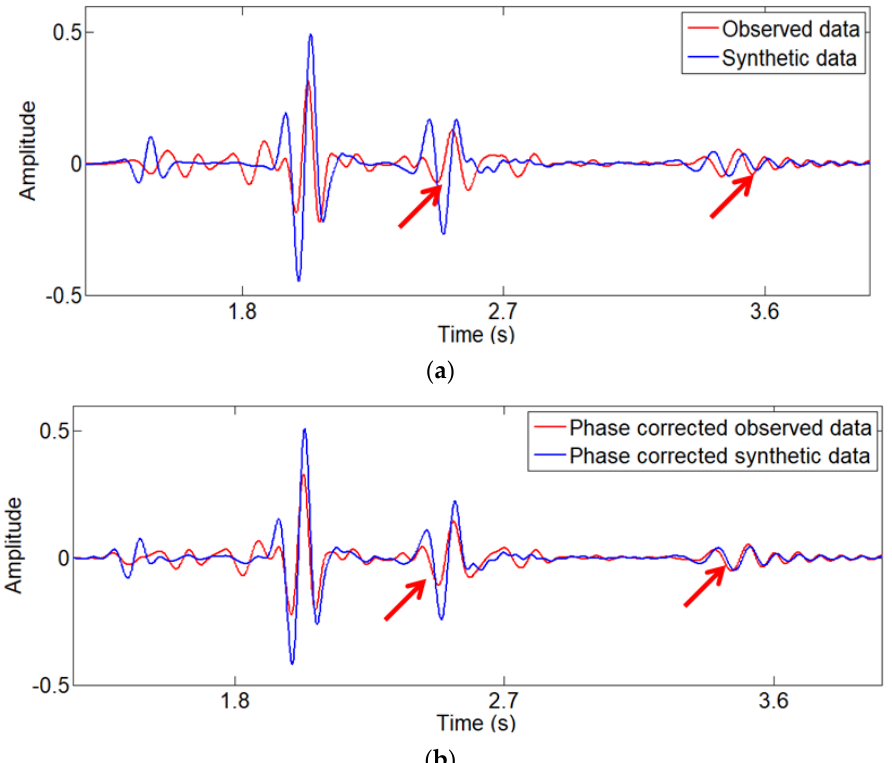
Figure 2. Windowed seismic data in the time-space domain and frequency-wavenumber domain; ( a , c ) are extracted from the red and blue rectangular boxes of Figure 1, respectively; ( b , e ) are the frequency-wavenumber domain amplitude information of ( a , d ), respectively; ( c , f ) are the 5 . 0 =  phase-corrected seismic data of ( a , d ) with , respectively.